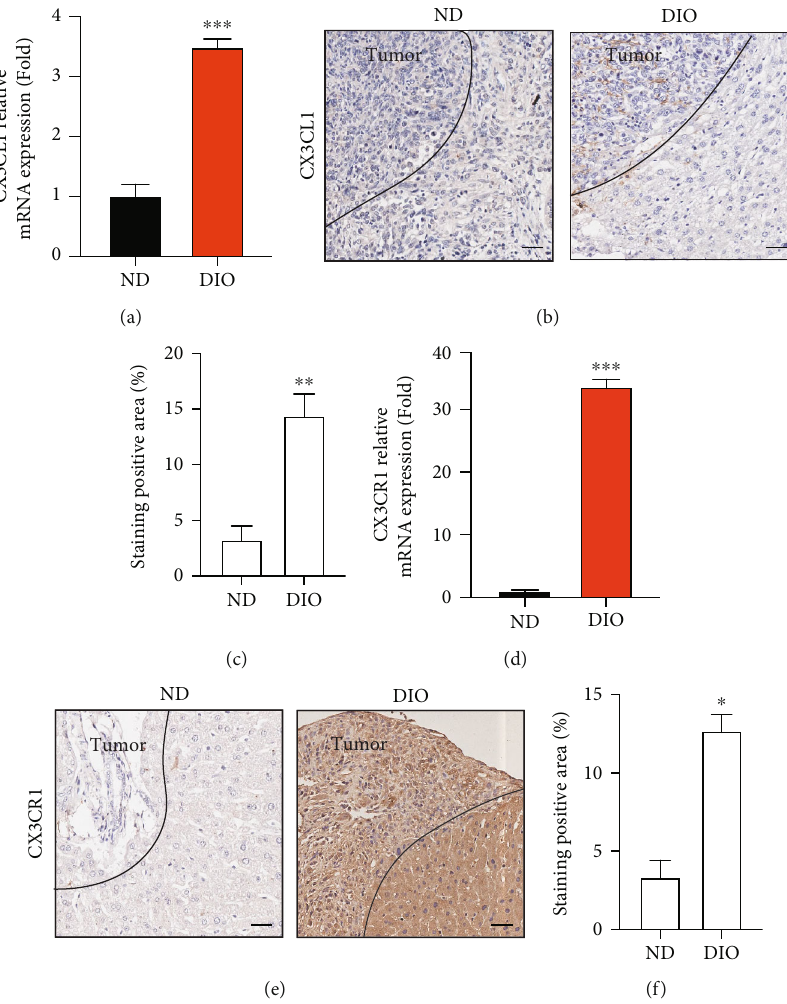
Figure 4: DIO increased expression level of CX3CL1 and CX3CR1 in liver metastasis of PDAC. (a) Relative mRNA levels of CX3CL1 in liver of ND mice and DIO mice after intrasplenic injection with 1 × 10 6 Panc02 cells ( n = 6 /group). (b) Representative immunohistochemical images of CX3CL1 staining in liver of ND and DIO. Scale bar, 20 μ m. (c) Bar graph showed the relative CX3CL1 staining positive rate. (d) Relative mRNA levels of CX3CL1 in liver of ND mice and DIO mice after intrasplenic injection with 1 × 10 6 Panc02 cells ( n = 6 /group). (e) IHC staining images of CX3CR1. Scale bar, 20 μ m. (f) Bar graph showed the relative CX3CR1 staining positive rate. ∗ P < 0 : 05 , ∗∗ P < 0 : 01 , and ∗∗∗ P < 0 : 001